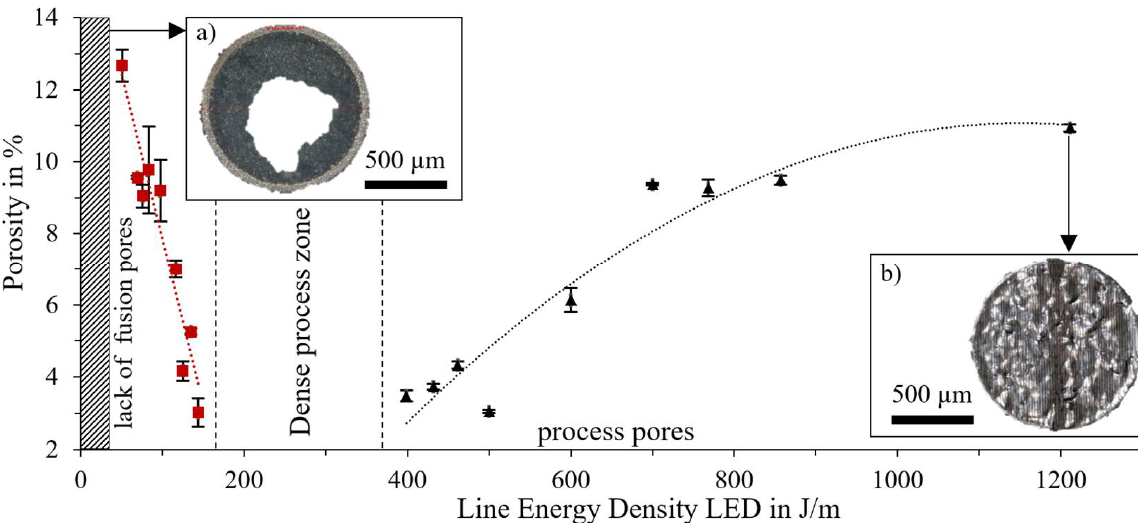
Figure 3. Definition of process windows as a function of LED to describe the porosity as a result of the pore formation mechanisms: ( a ) representation of the process limit at the lowest LED due to unstable structures, ( b ) representation of geometric surface deviations due to melt pool turbulence.